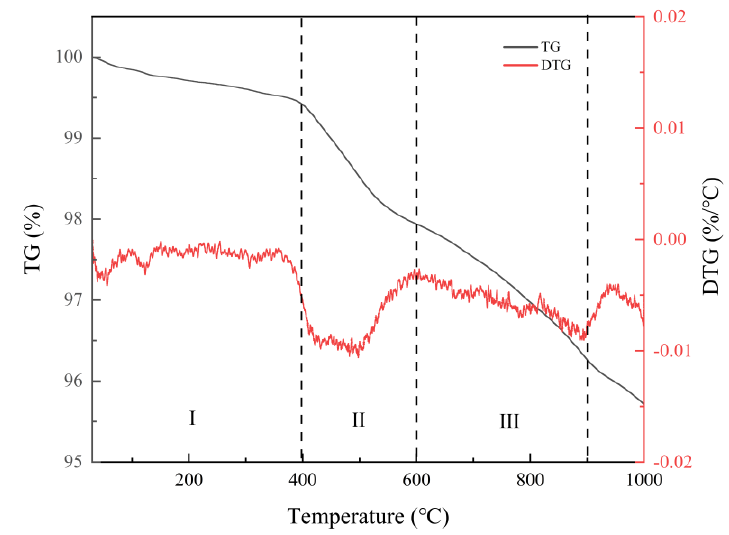
Figure 2. DTG analysis diagram of coating raw materials.